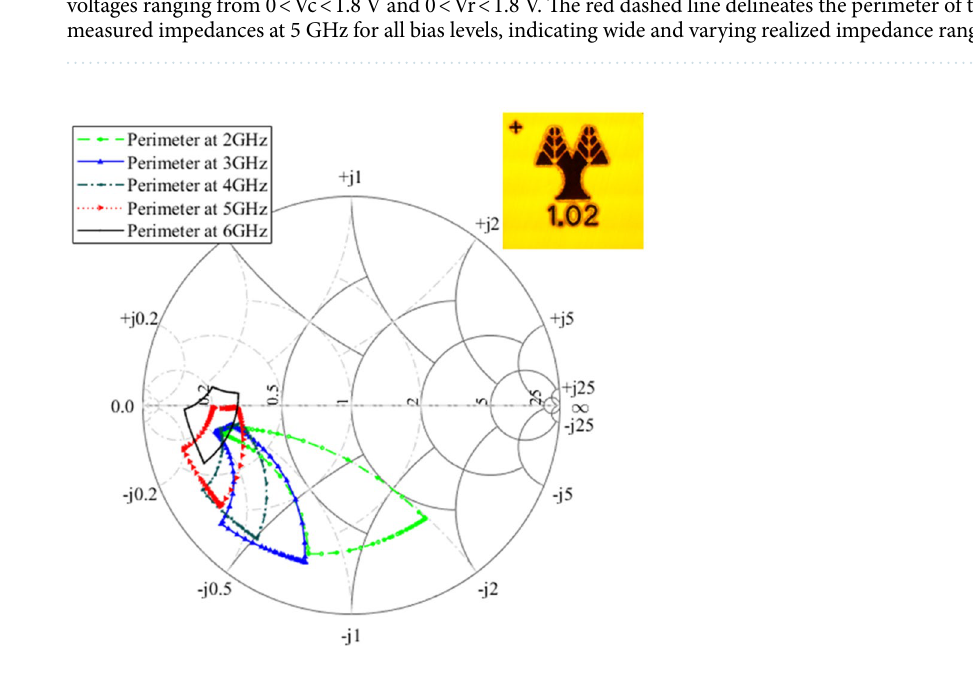
Figure 5. Smith chart illustrating the de-embedded measured loading element impedance perimeters at various frequencies of ASIC Design